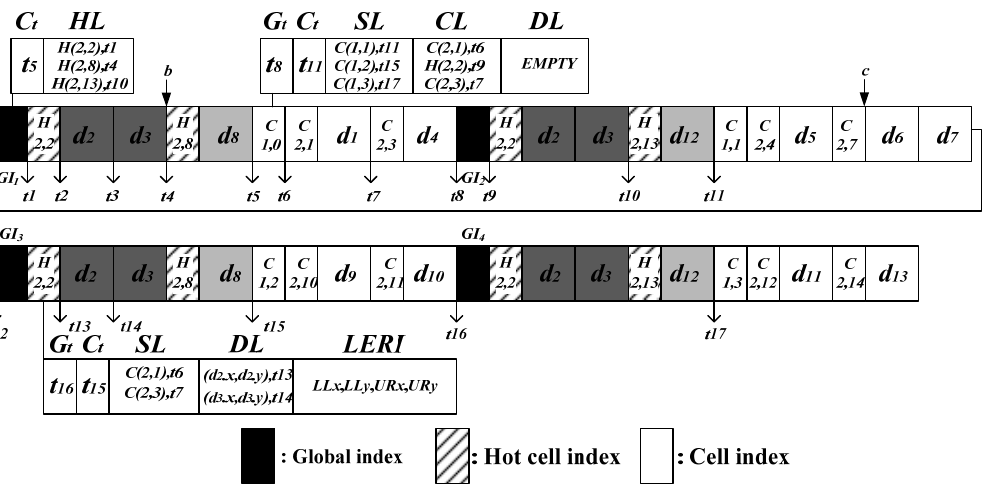
Figure 5. N on-flat broadcast program with the distribution of the spatial air index.